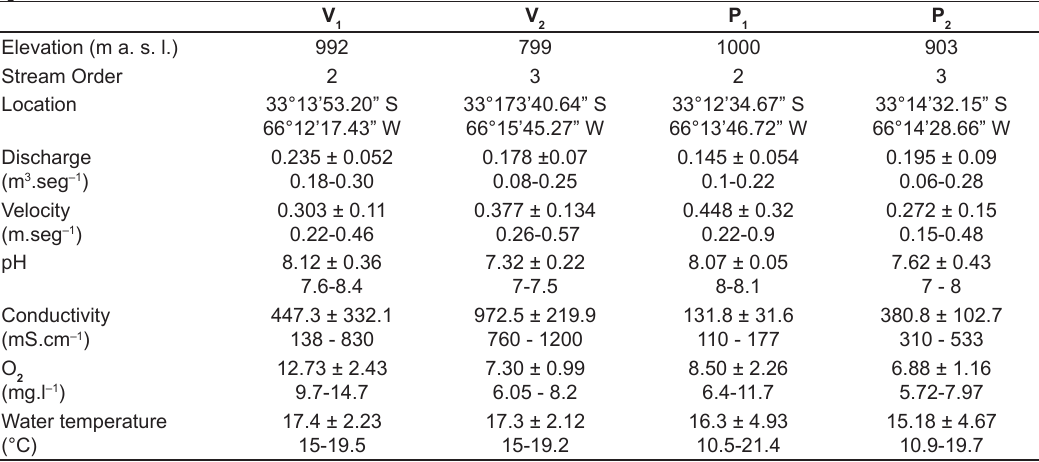
Table 1. Values (mean ± standard deviation [SD]) of the measured physical, chemical and geographic variables in the study sites of the Bebedero basin (San Luis). V Las Chacras P 2